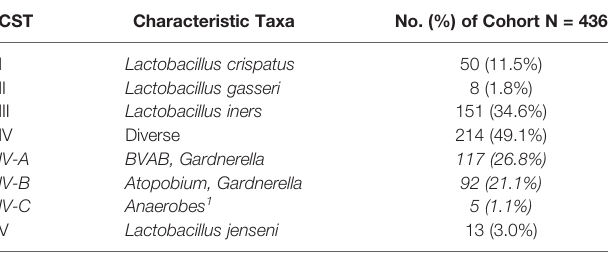
TABLE 1 | Distribution of Vaginal Microbiome Community State Type among Study